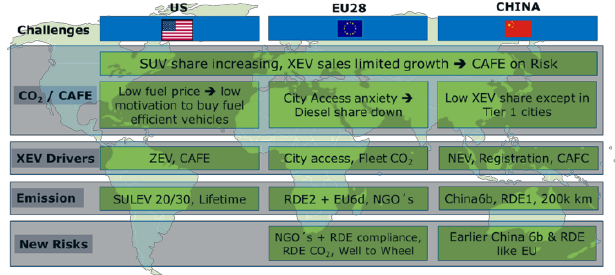
Fig. 1. Global and regional challenges for the